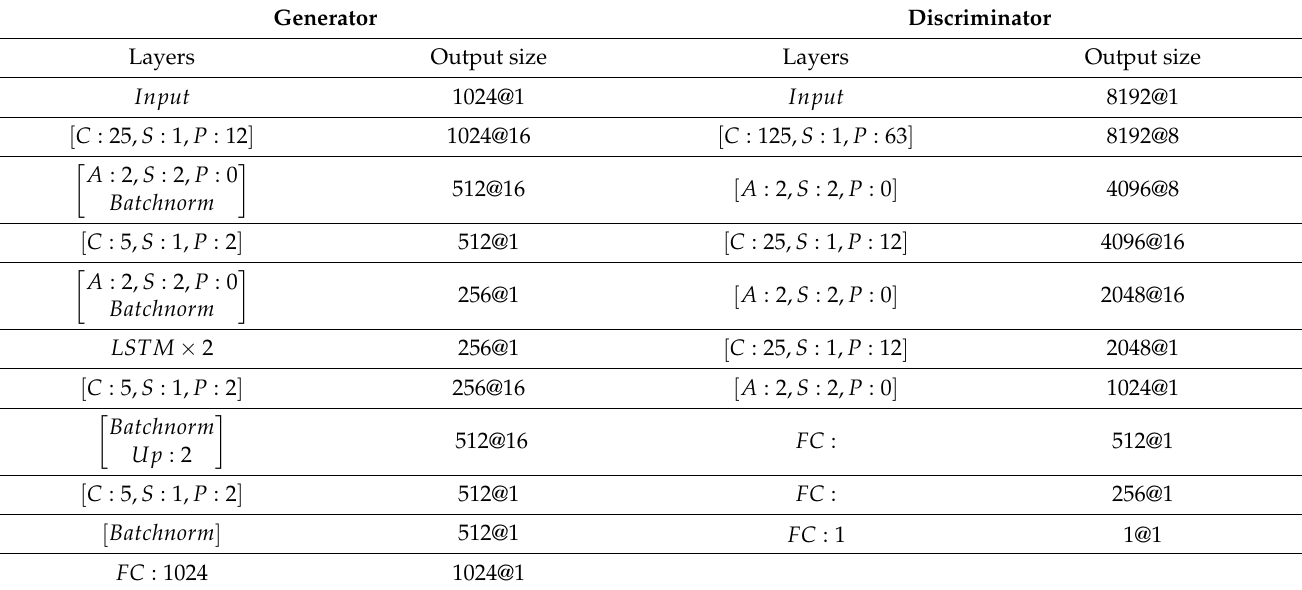
Table 2. The detailed parameters of the proposed Generator and Discriminator.